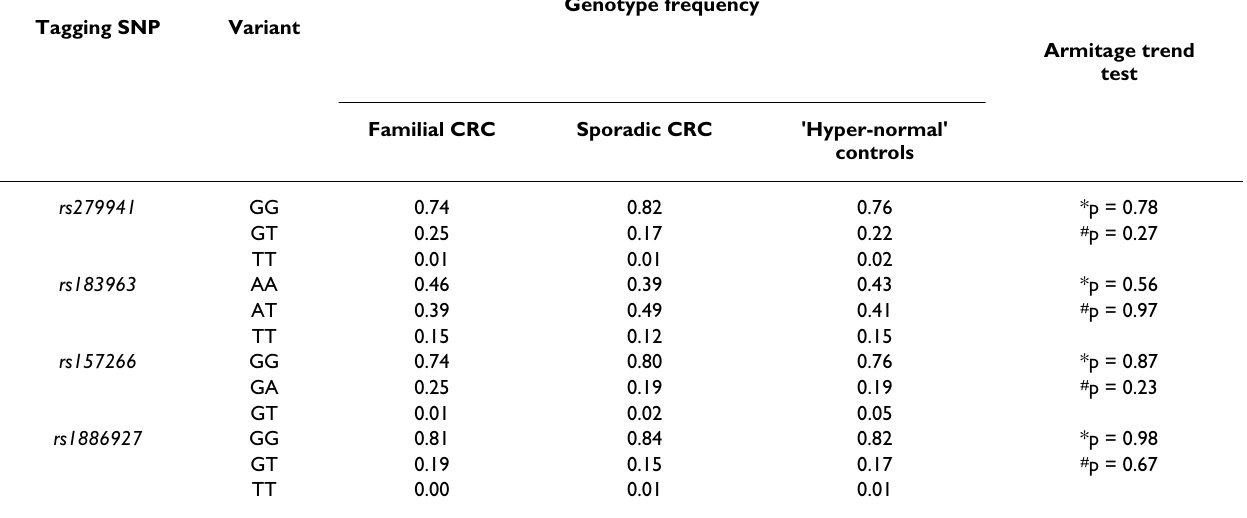
Table 3: Genotype frequencies of SLC10A2 tagging SNPs Tagging